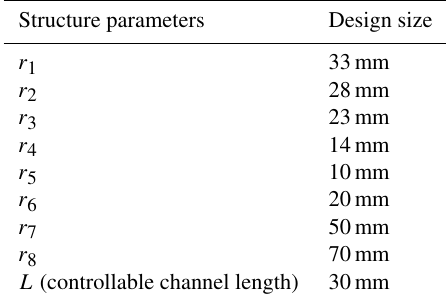
Table 1. Design of magnetic circuit size. Structure